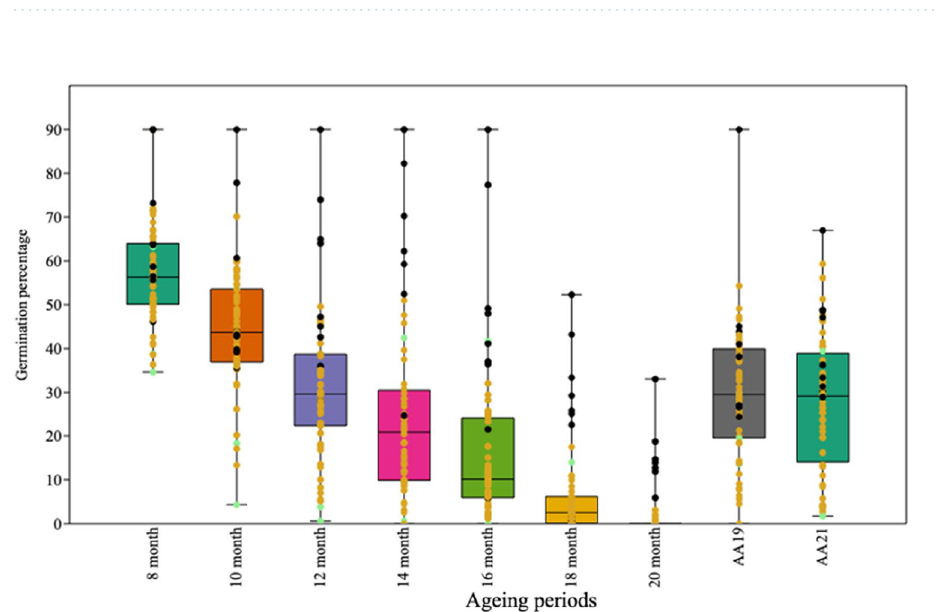
Figure 1. Box and jitter plot of germination percent after natural (8–20 months) and accelerated ageing (AA) (Black, Green, and Yellow colour dots indicate Black, Green, and Yellow seed coat colour genotypes).